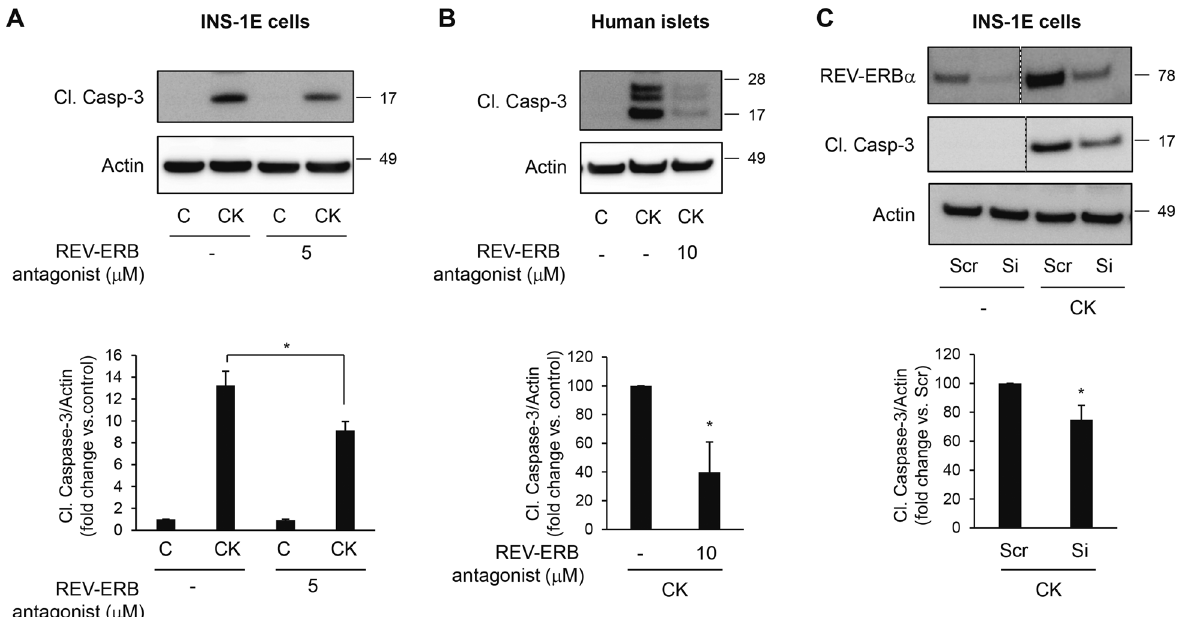
Fig. 6 Negative modulation of REV-ERB α protects β -cells and human islets from cytokines-induced apoptosis. INS-1E cells ( A ) or human islets ( B ) were exposed or not to pro-in fl ammatory cytokine mix (CK) in the presence or absence of REV-ERB antagonist (SR8279, 5 or 10 μ M for 24 h). Cleaved Caspase-3 and actin (loading control) levels were analyzed by western blot ( n = 3 – 4 independent experiments). C REV-ERB α was silenced in INS-1E cells by siRNA. Scramble RNA (Scr) was used as a control. Cells were then exposed to pro-in fl ammatory cytokine mix (CK). Levels of REV-ERB α , Cl. Caspase-3, and actin were analyzed by western blot ( n = 3 independent experiments). For REV-ERB α and Cl. Caspase-3 images, lanes were run on the same gel but were non-continuous (as indicated). Data are expressed as mean ± SEM; * P < 0.05 vs.